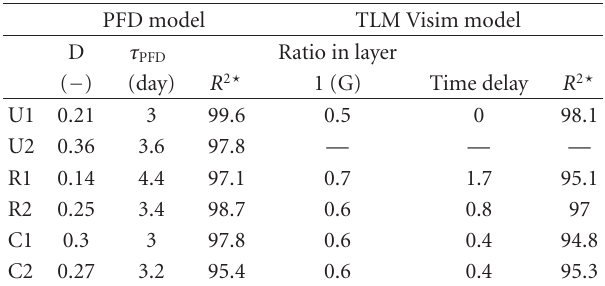
Table 2: Simulation results of hydraulic models ( ∗ Pearson correla- tion).